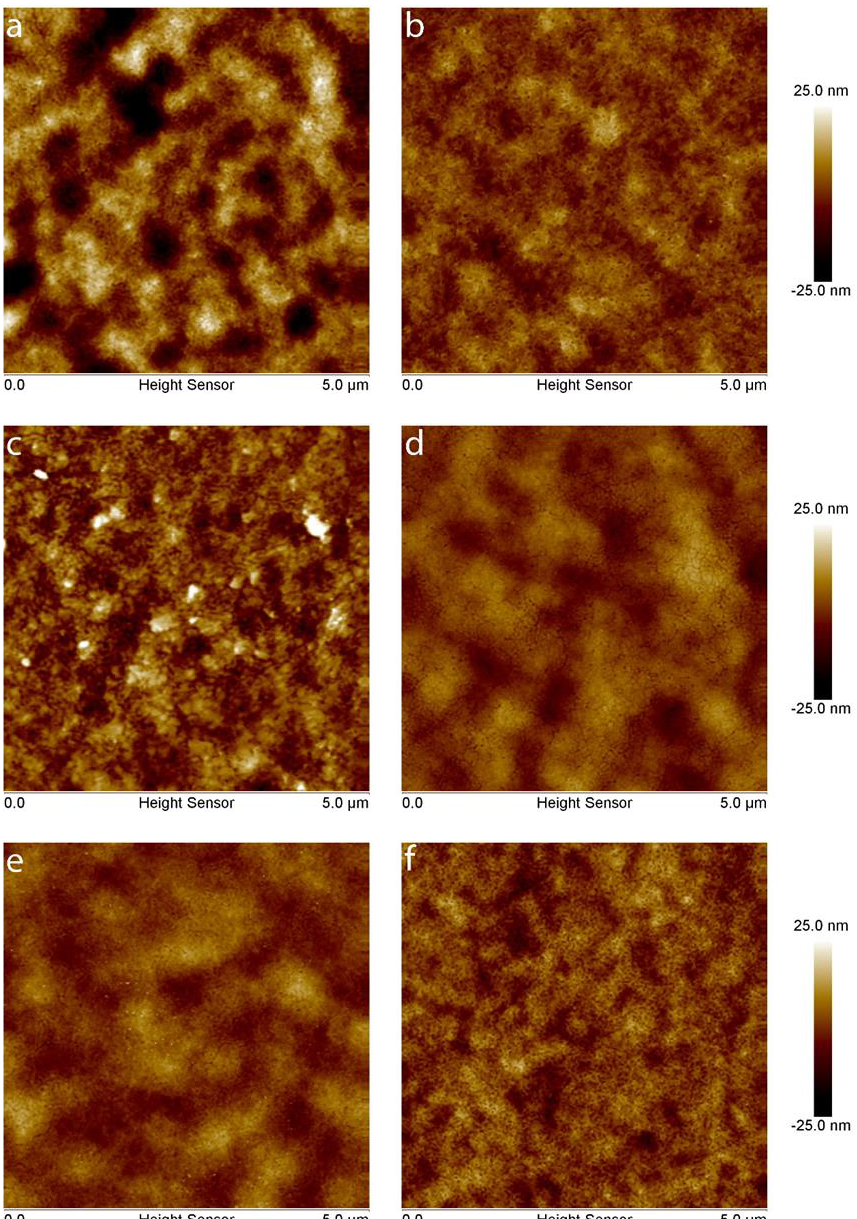
Figure 8. AFM images of the BLFSO films processed at 600 °C on Pt/TiO 2 /SiO 2 /Si ( a ), silicon ( b ), sapphire ( c ), corundum ( d ), fused silica ( e ) and glass ( f ). Table 1. Roughness of selected substrates and films calculated as RMS.